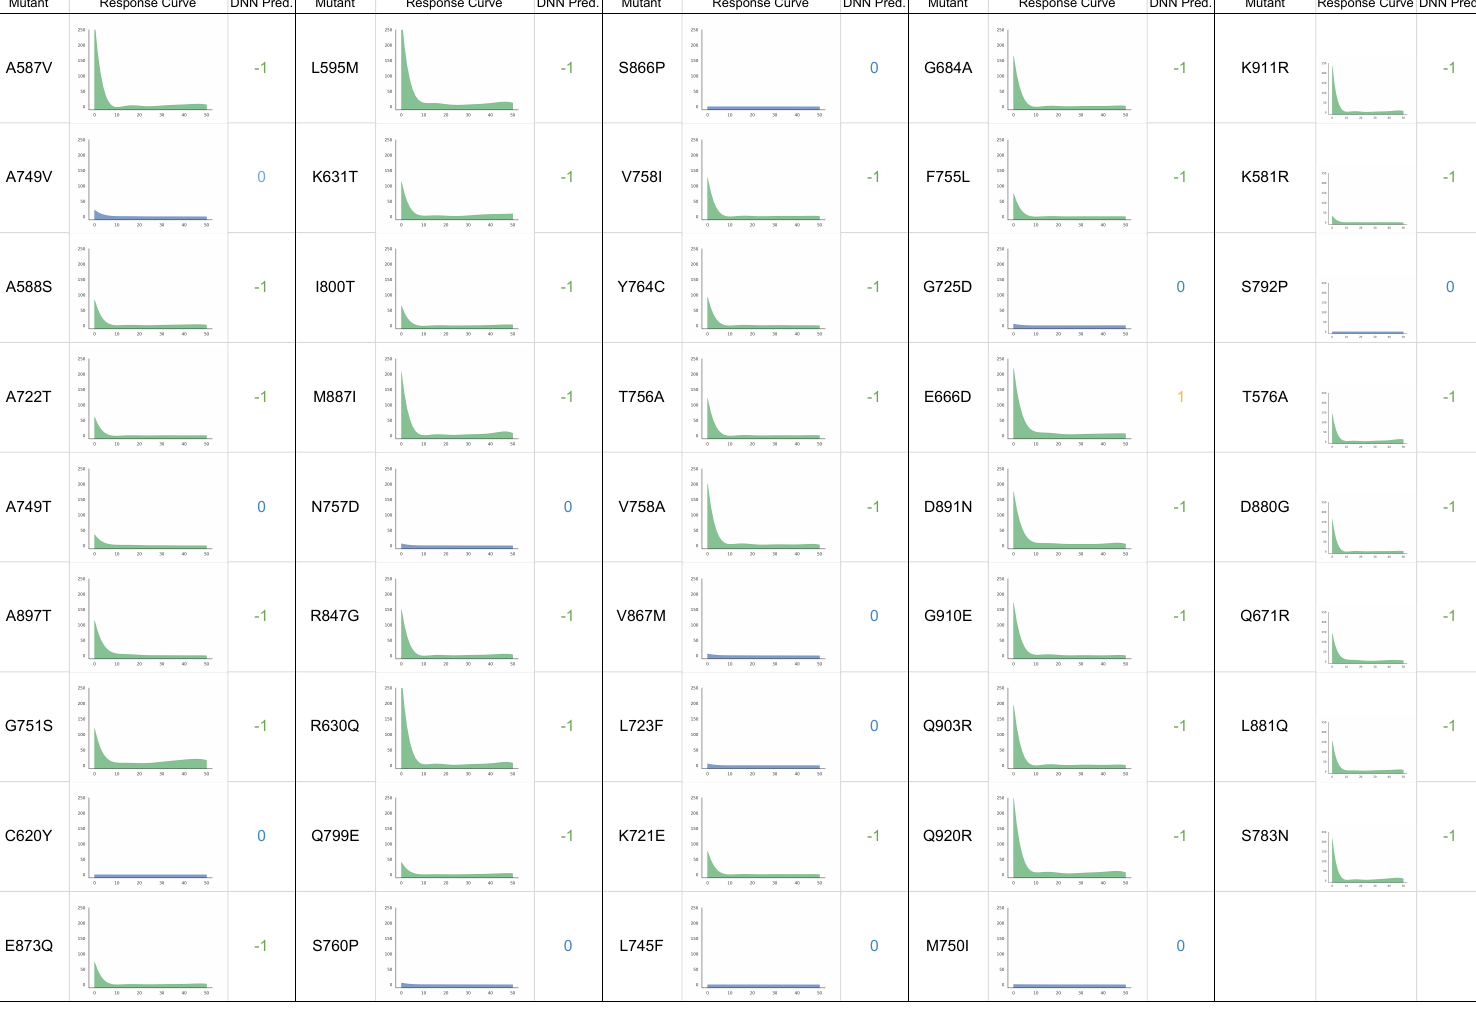
Figure 6. Experimental drug-response curves of AR mutants treated with darolutamide with corresponding DNN predictions. − 1 = antagonized, 0 = non-responsive, and 1 =